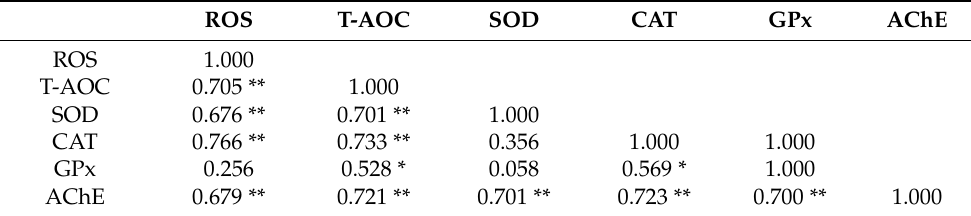
Table 5. Pearson correlation matrix on biochemical parameters in T. japonicus exposed to K. mikimotoi